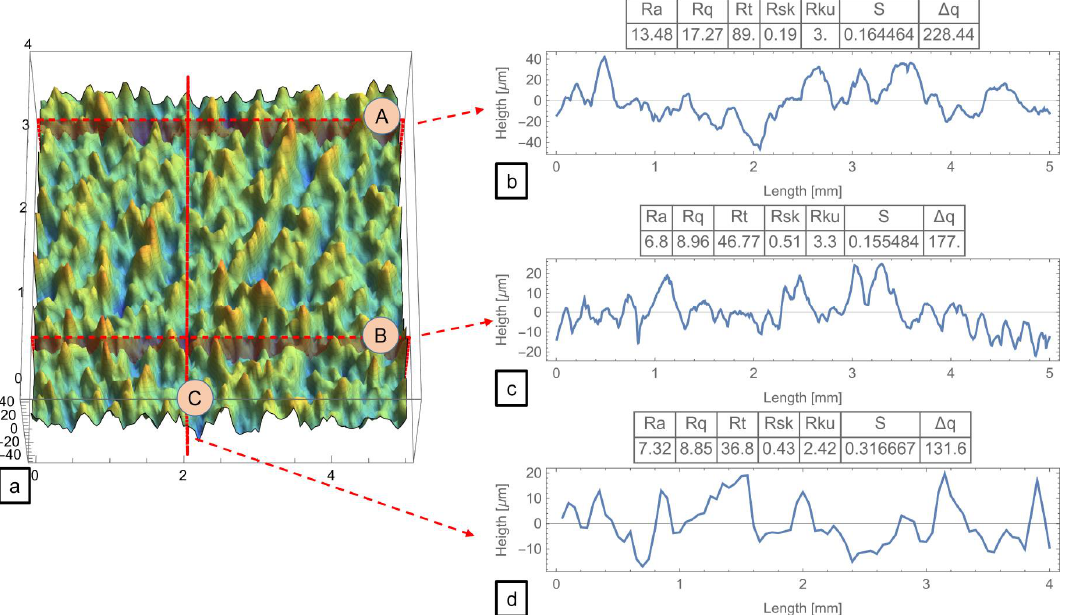
Figure 5. 3D surface map at 45° slope (a): profiles A ( b ) and B ( c ) extracted horizontally and profile C extracted vertically ( d ).